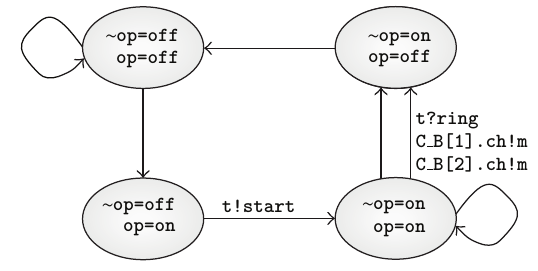
Figure 6: An example model for system 𝐶 𝐴 .